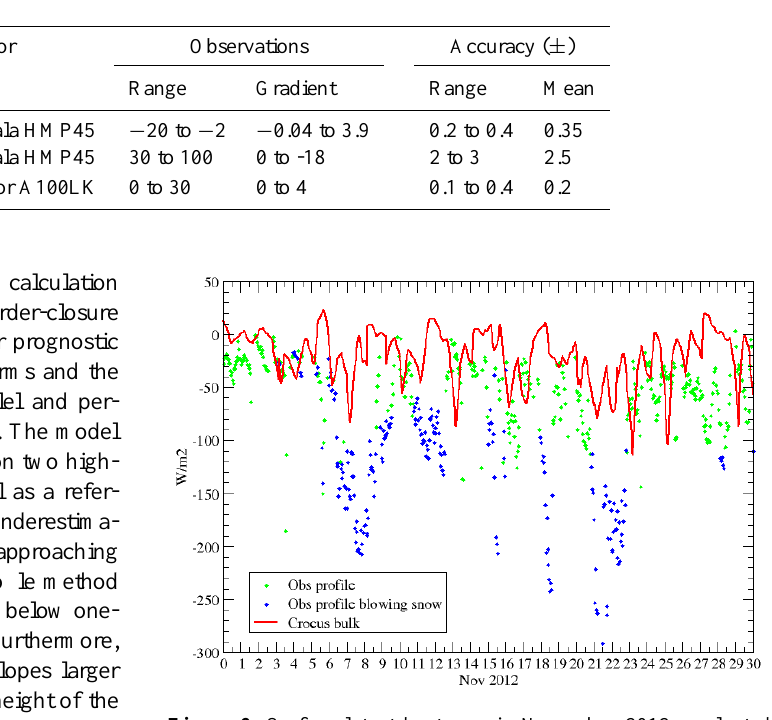
Table 2. The observed range and gradients (difference between levels 5 and 2 on the mast) of temperature, RH wri and wind speed, and factory stated range of instrumental accuracy.